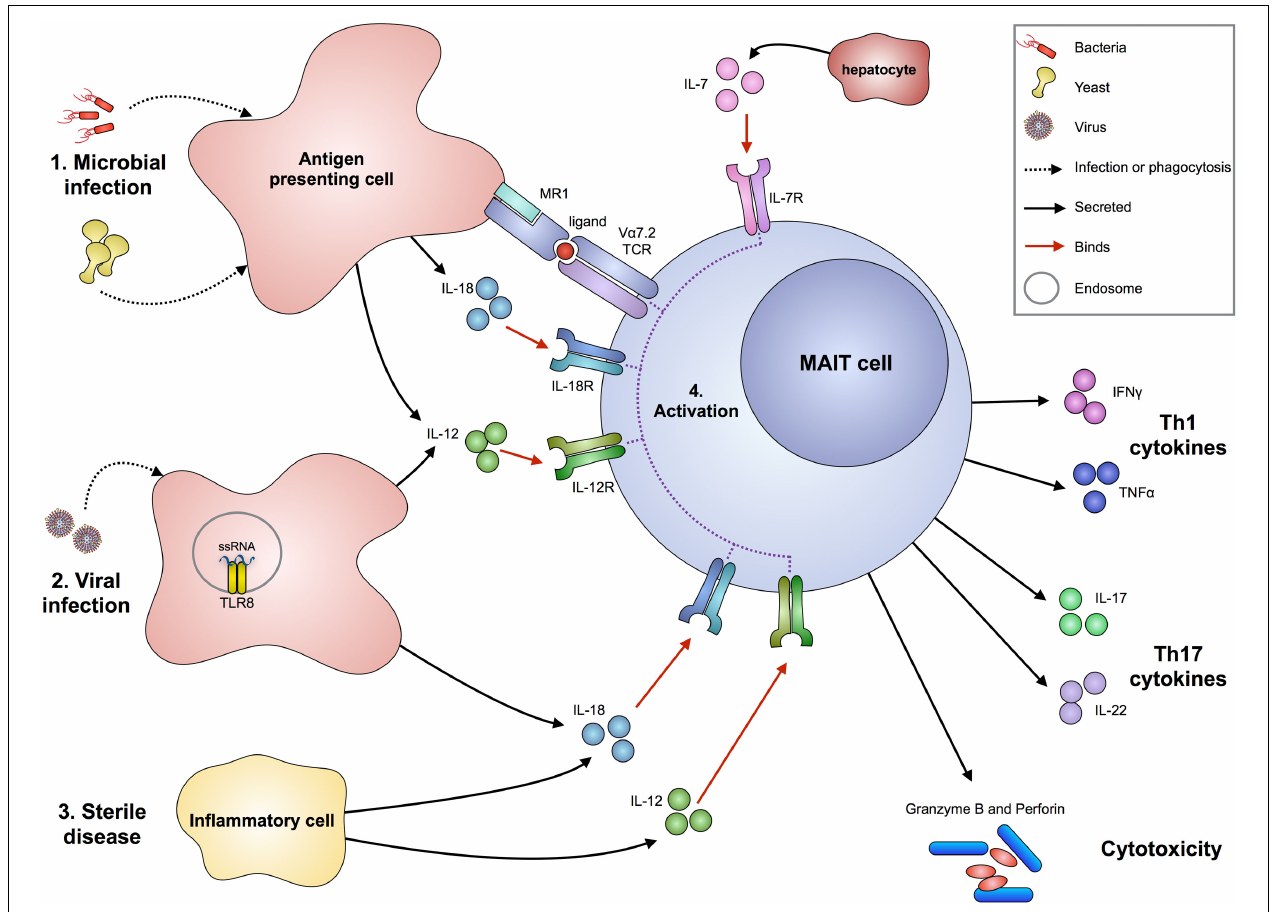
can stimulate MAIT cells through detection of their molecular patterns by pattern recognition receptors, such as ssRNA by TLR8 on antigen presenting cells, resulting in the production of IL-12 and IL-18. In sterile disease (3), such as autoimmunity, cells that pathologically express cytokines IL-12 and IL-18 can activate MAIT cells. The activation of MAIT cells (4) results in the production of Th1 cytokines IFN γ and TNF α , Th17 cytokines IL-17 and IL-22 (particularly by small intestine-derived MAIT cells), and release of perforin and granzyme B to directly kill infected